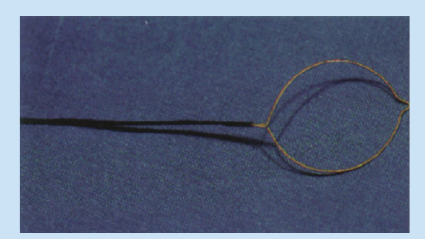
Fig. 3. Microvena goose neck snare.